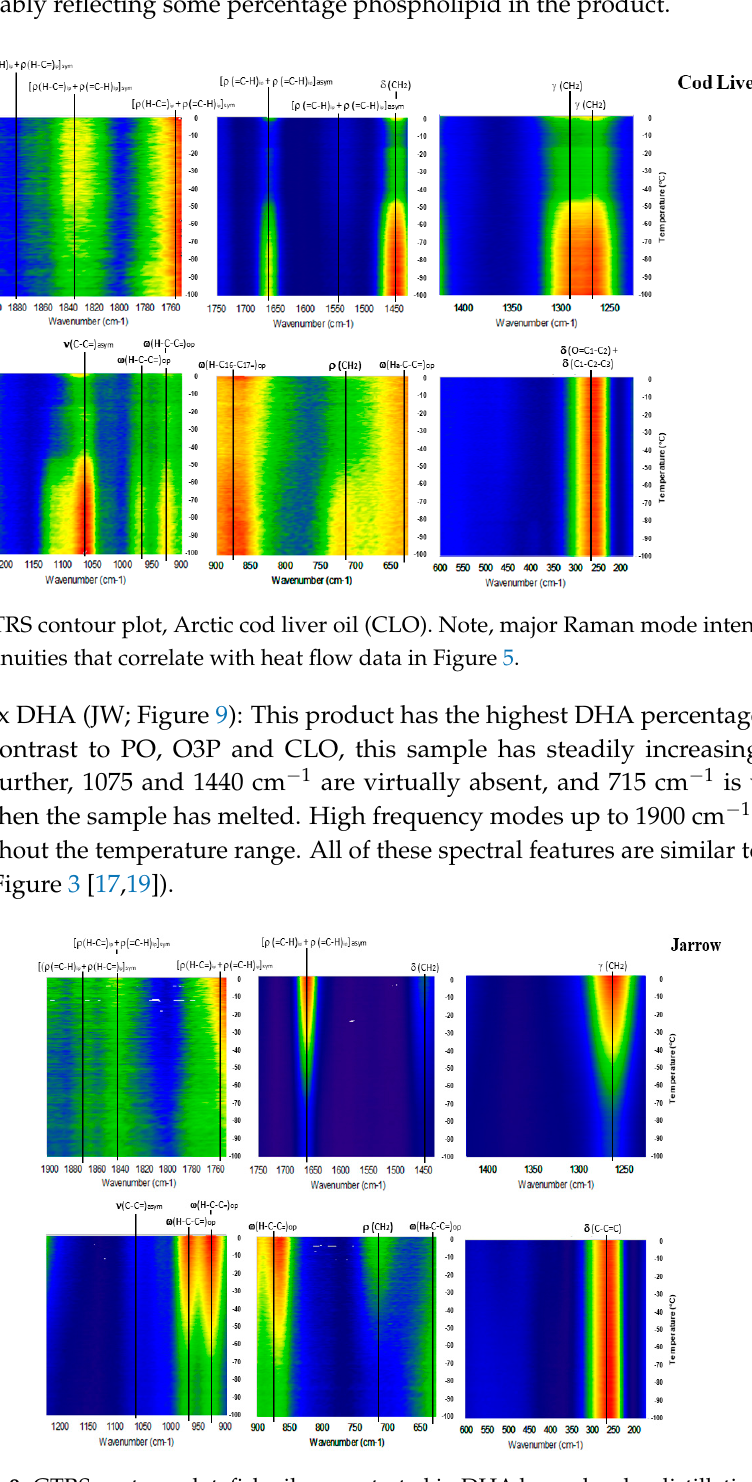
Figure 7. GTRS contour plot, Anchovy and sardine oil (O3P). Note, major Raman mode intensity